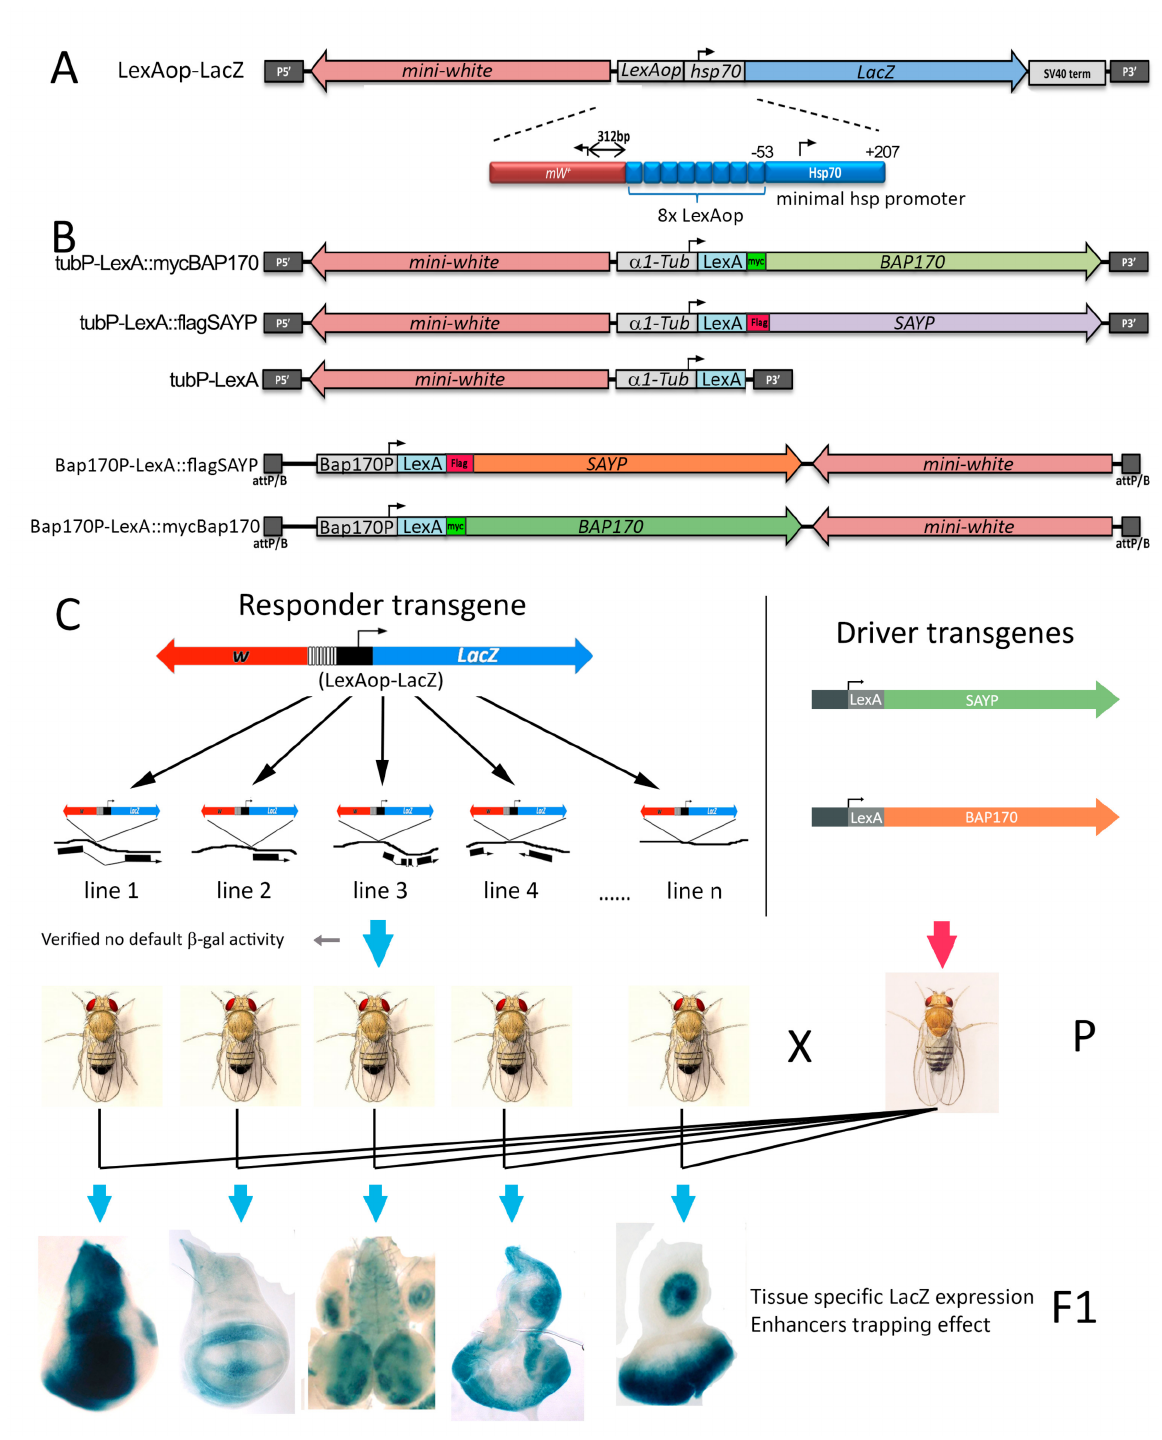
Figure 1. Schematic representation of the transgenes and rationale for in vivo targeting of the PBAP to a reporter promoter. ( A ) The P element-based LexAop:LacZ responder construct includes not only the dominant marker white gene, but also the LacZ reporter driven by the core promoter ( − 44 to +204) of the Drosophila hsp70 gene. The region upstream of the hsp70 promoter harbors 8x Escherichia coli LexA repressor binding elements ( LexAop operators). ( B ) Scheme of the driver transgenes designed for LexA:BAP170, LexA:SAYP, and LexA ubiquitous expression ensured by the alpha - tubulin gene promoter (P element-based constructs, top) or the promoter of the BAP170 gene (attB/P-based construct, bottom). ( C ) Rationale of the procedure (see text) used to test the effect of PBAP targeting to the core promoter of the LexAop - LacZ reporter transgenes inserted in different sites of the Drosophila